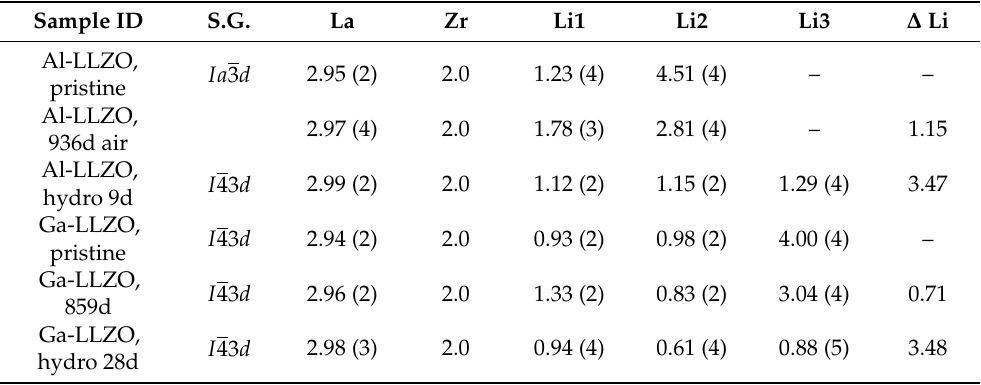
Table 5. Refined site occupation numbers (per Formula Unit; pfu) of Al- and Ga- stabilized LLZO for the samples listed in Table